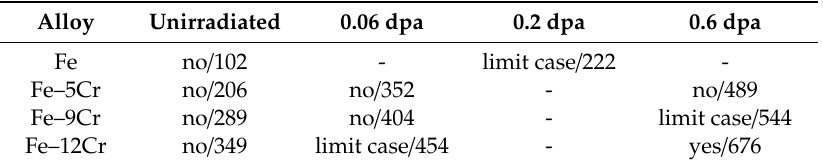
Figure 1. Measured engineering stress-strain curves. ( a ) Unirradiated and ( b ) irradiated conditions of the same alloys (0.2 displacements per atom (dpa) for Fe and 0.6 dpa for Fe-Cr alloys). Table 2. Appearance of yield drops (yes, no, or limit case) and measured average yield stress (0.2% proof stress σ 0.2 or upper yield stress σ yu , whichever was applicable) in units of MPa. The error of the yield stress was typically within